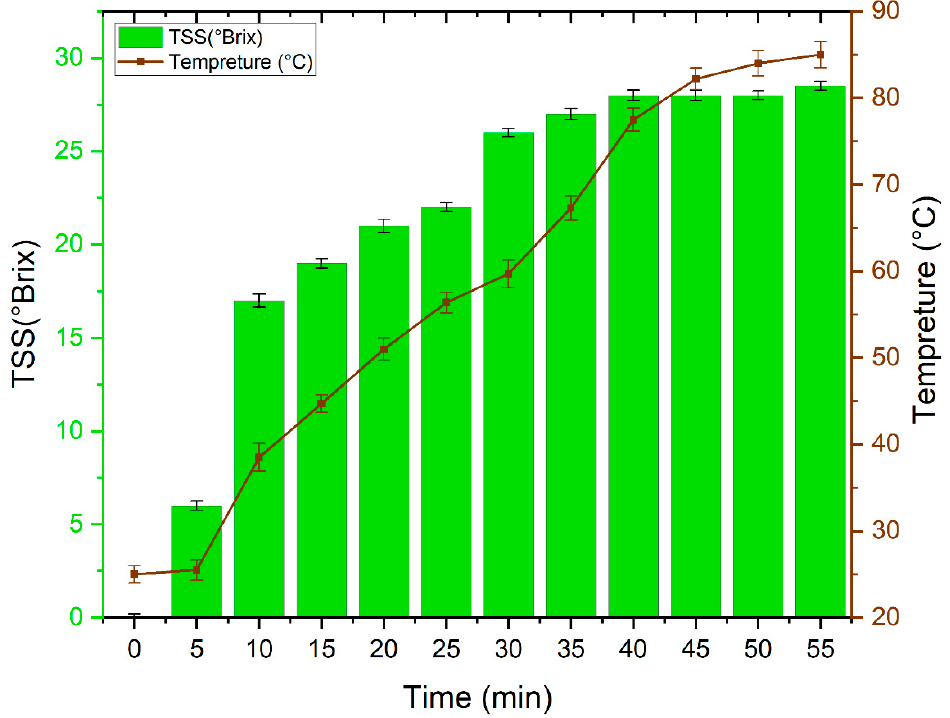
Figure 1. Evolution of Total Soluble Solids (TSS) with time during the direct sugar extraction at different temperatures.